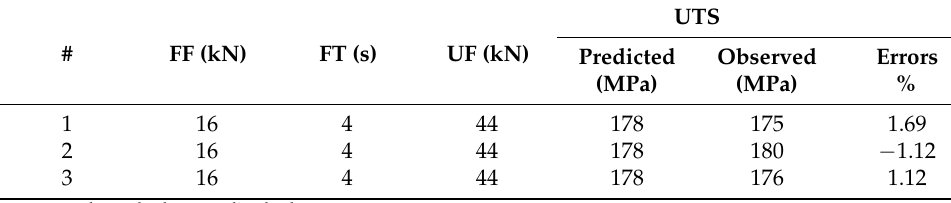
Table 6. Validation tensile test results.